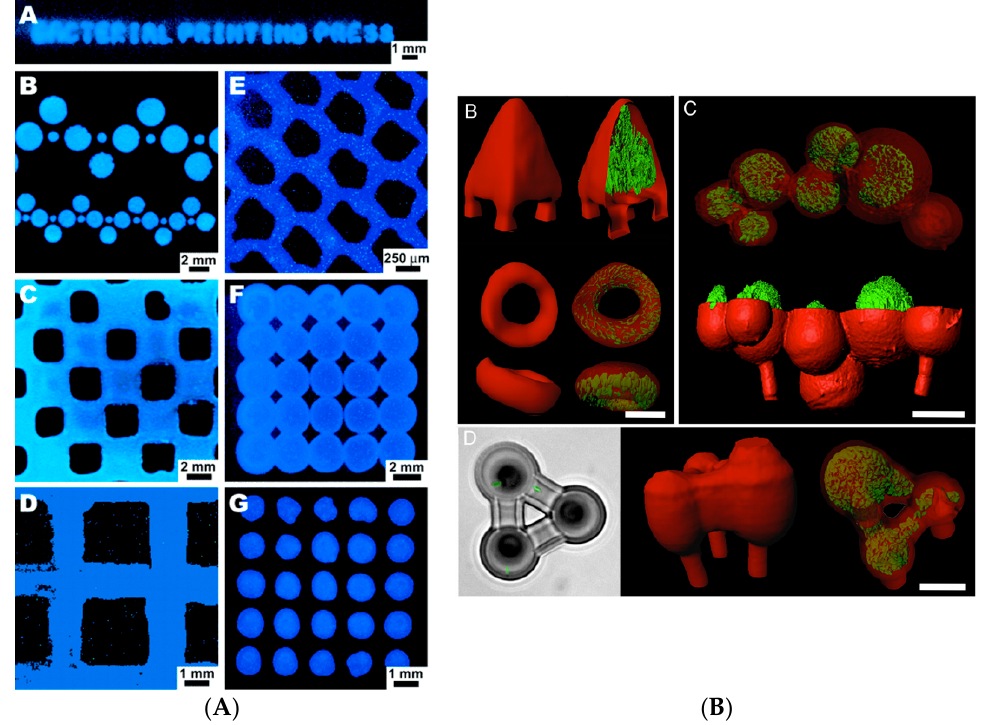
Figure 1. ( A ) Various patterns of Vibrio fischeri colonies printed on the agar surface in a petri dish using soft lithography. Adapted with permission from [5]. Copyright (2005) American Chemical Society. ( B ) Confocal fluorescence images show gelatin-based micro-3D printing in the presence of Pseudomonas aeruginosa microcolonies [6].